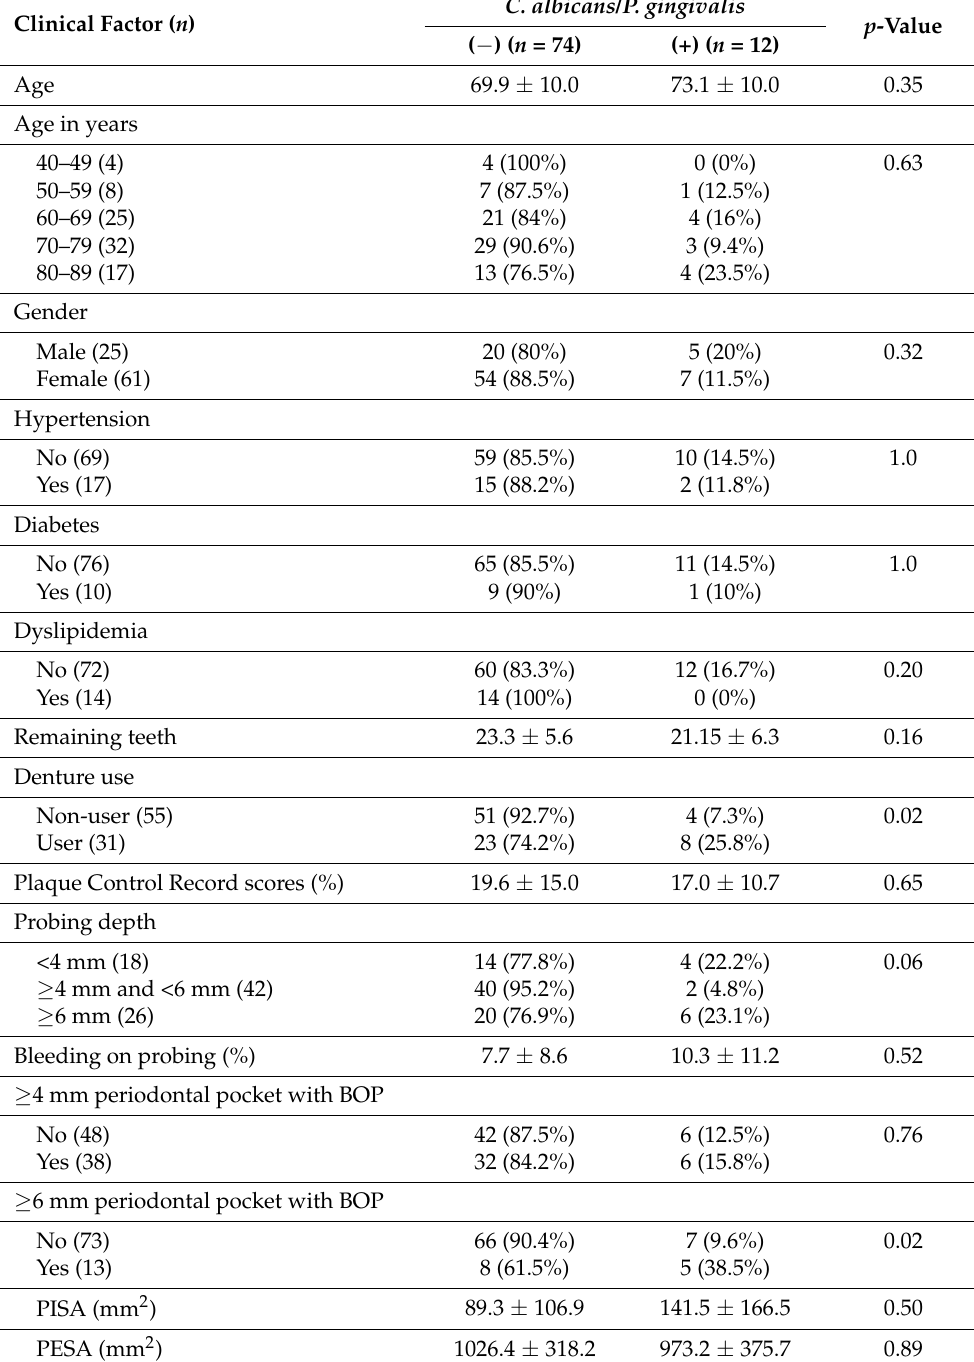
Table 3. Relationship between oral C. albicans / P. gingivalis and clinical